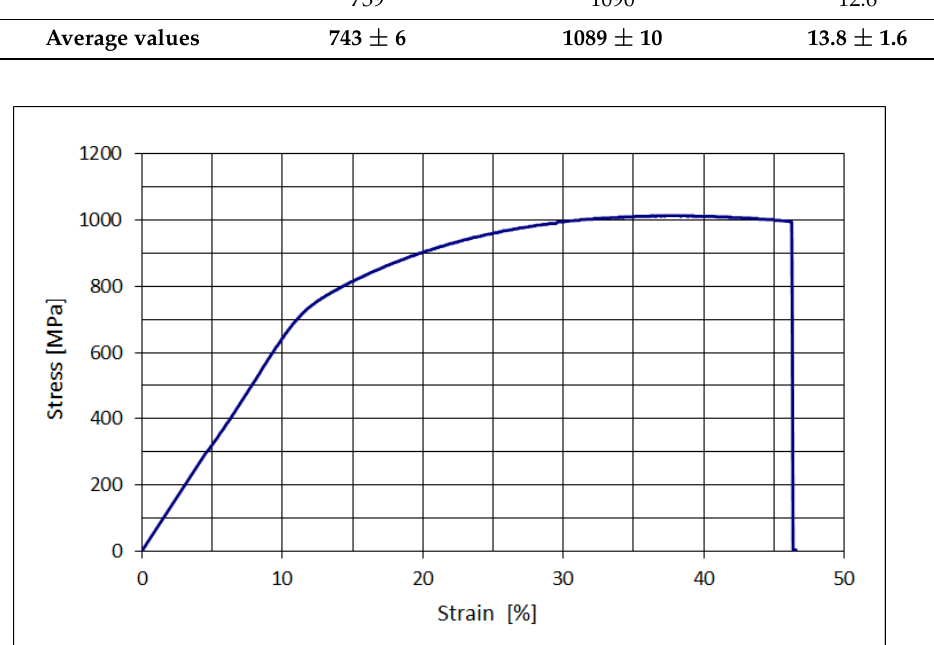
Figure 4. The stress-strain curve for the specimen Re-1 (0.8% Re).